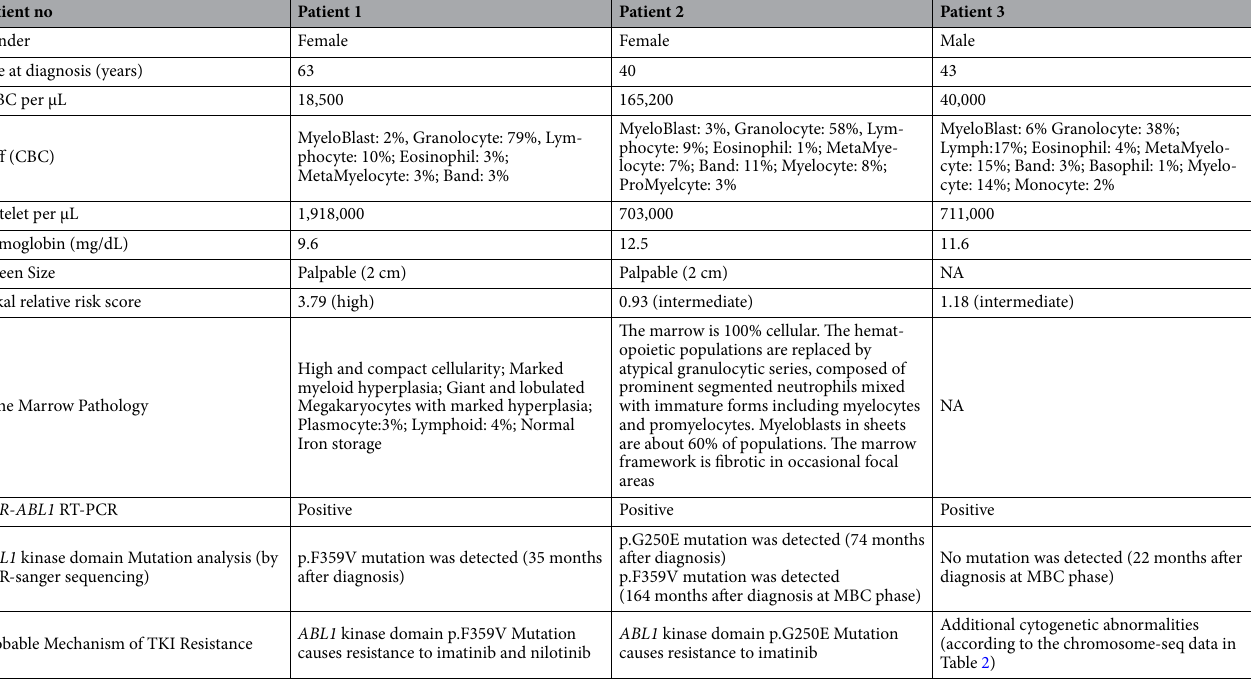
Table 1. Clinical and laboratory findings for the CML patients at diagnosis/chronic phase. Dx diagnosis, NA not available, RT-PCR reverse transcriptase PCR, TKI tyrosine kinase